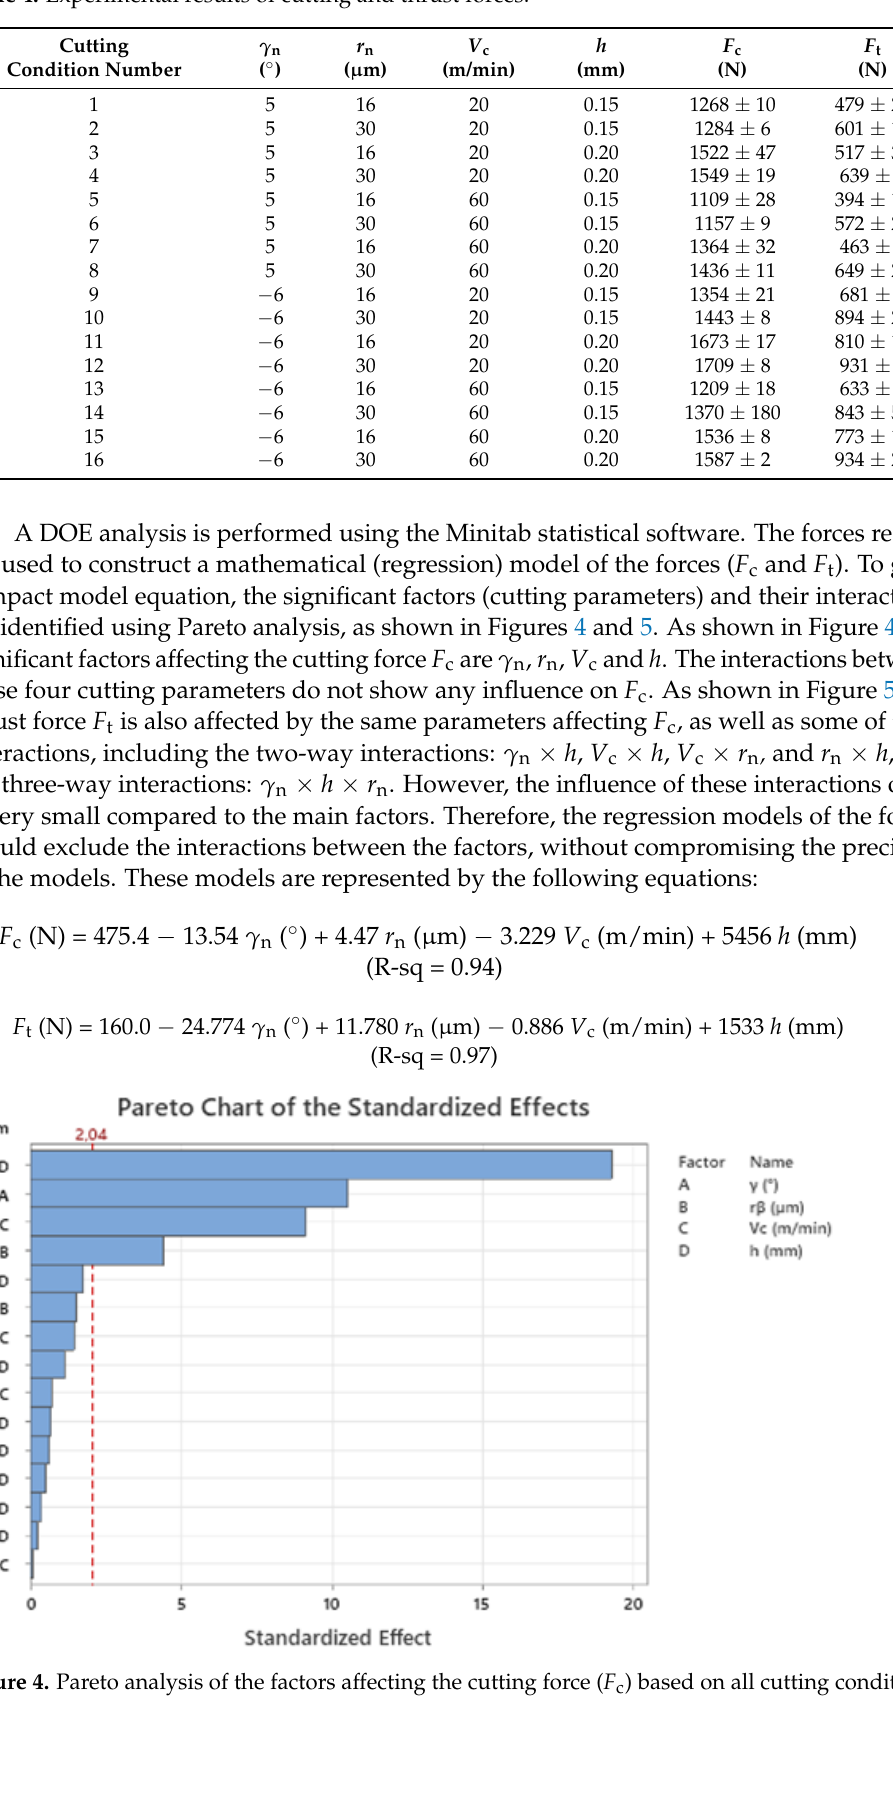
Figure 5. Pareto analysis of the factors affecting the thrust force ( F t ) based on all cutting conditions. The graphical representations of the influence of the cutting parameters on the F c and F t forces are shown in Figures 6 and 7. These figures show that both F c and F t forces de- crease when the tool rake angle ( γ n ) and cutting speed (V c ) increase, and they increase with the tool edge radius ( r n ) and uncut chip thickness ( h ). To explain some of these results, as well as those of the CCR and residual stresses, the cutting process should be viewed as a forming process that takes place in the compo- nents of the cutting system, which are so arranged that the external energy applied to this system causes the separation of a layer of material from the bulk workpiece [38]. The pro- cess of physical separation of a solid body into two or more parts is known as fracture. Therefore, factors affecting the fracture strain, such as state of stress (stress triaxiality and Lode parameter), strain rate, and temperature, also affect metal cutting results (forces, temperatures, CCR, surface integrity, etc.) [39 – 41].